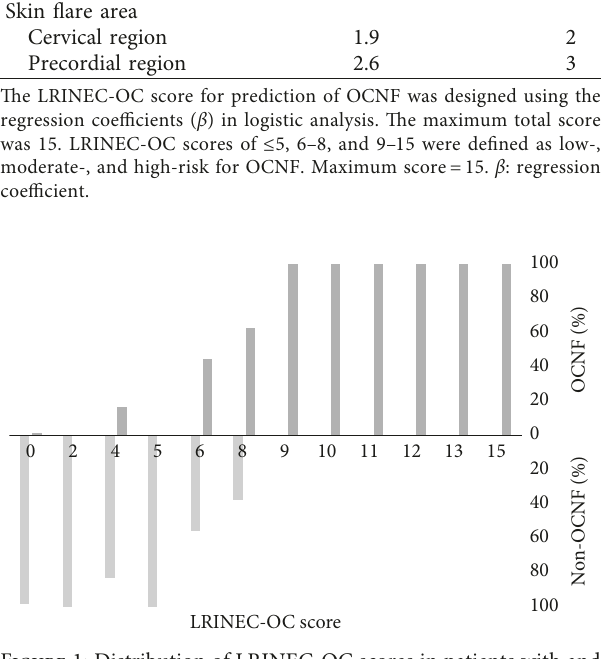
Figure 1: Distribution of LRINEC-OC scores in patients with and without OCNF. The percentages of OCNF patients with scores of 9–15 were